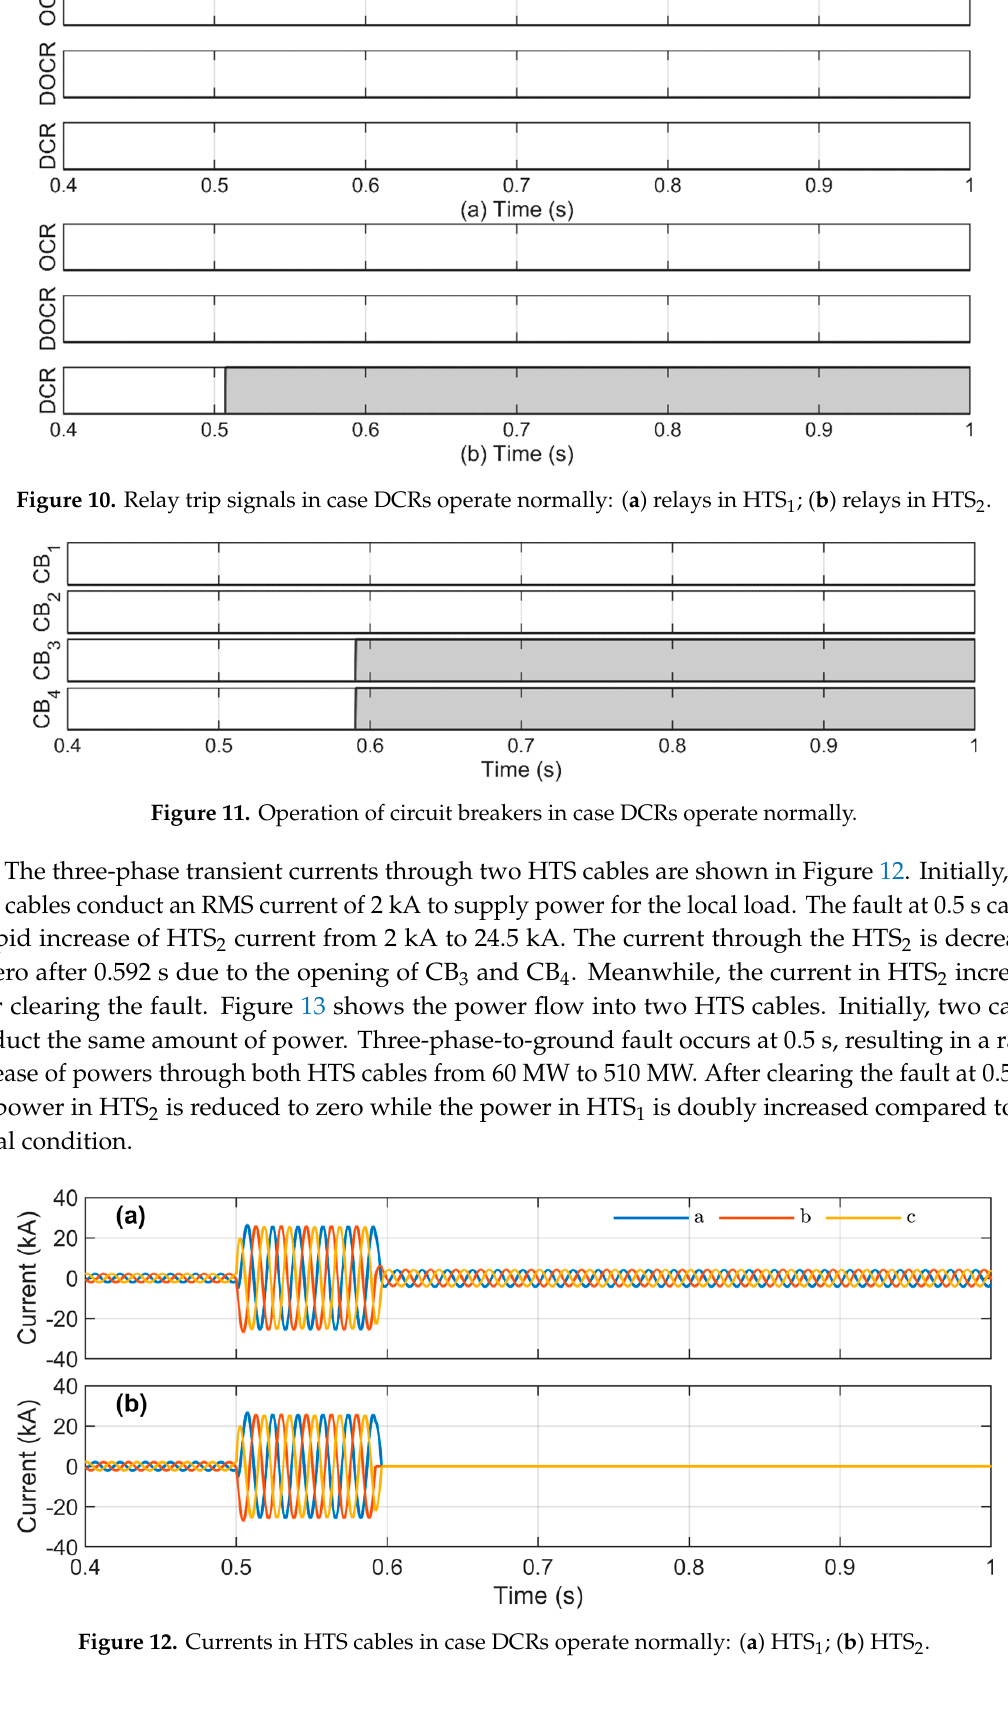
Figure 13. Conducted power in HTS cables in case DCRs operate normally. The HTS cable resistances are shown in Figure 14, which illustrates that the cable resistances are increased when the fault occurs. Due to the geometric structure of the HTS cable, the increased resistance of former phase A is smallest whereas it is highest in case of former phase C. The temperatures of the HTS cables shown in Figure 15 indicate that the temperature of former phase C is the highest (~76 K) compared to other phases. Figure 14. HTS cable resistances in case DCRs operate normally: ( a ) HTS 1 ; ( b ) HTS 2 .